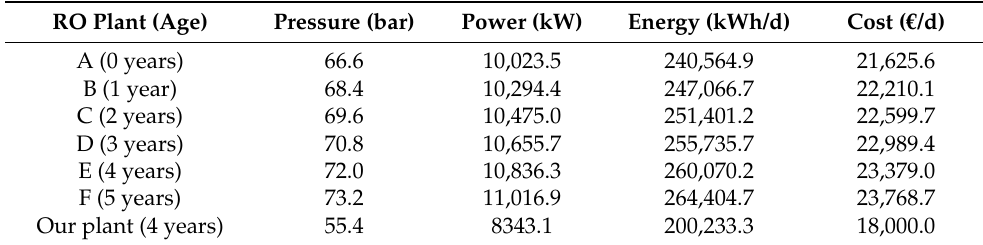
Table 3. Plant comparison under different scenarios .